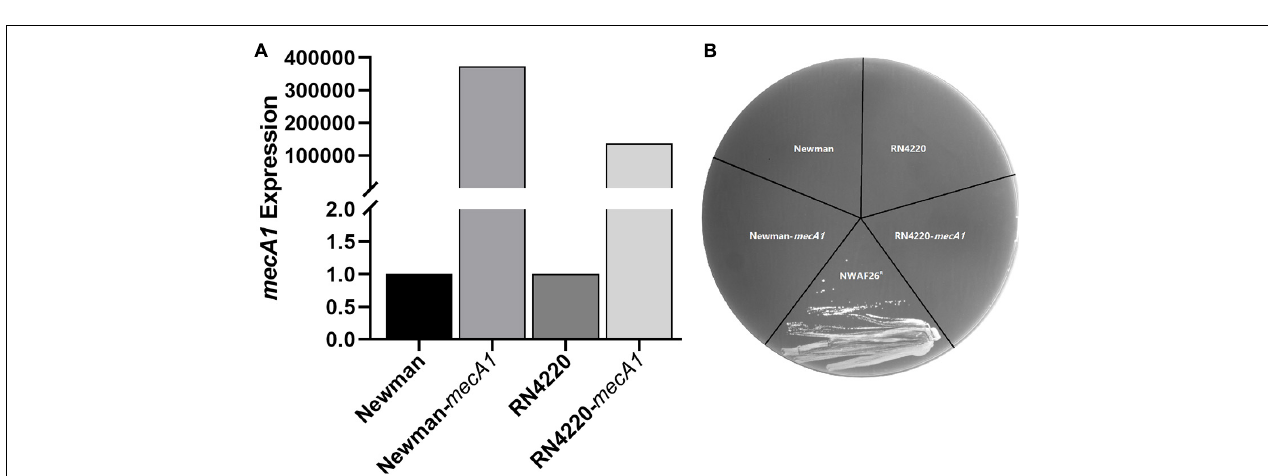
FIGURE 2 | Construction and oxacillin susceptibilities of mecA1 overexpression strains. The mecA1 gene from S. sciuri NWAF26 was introduced into the methicillin sensitive S. aureus strains RN4220 and Newman by shuttle vector pSE1, respectively. (A) The expression level of mecA1 were measured by qRT-PCR. (B)